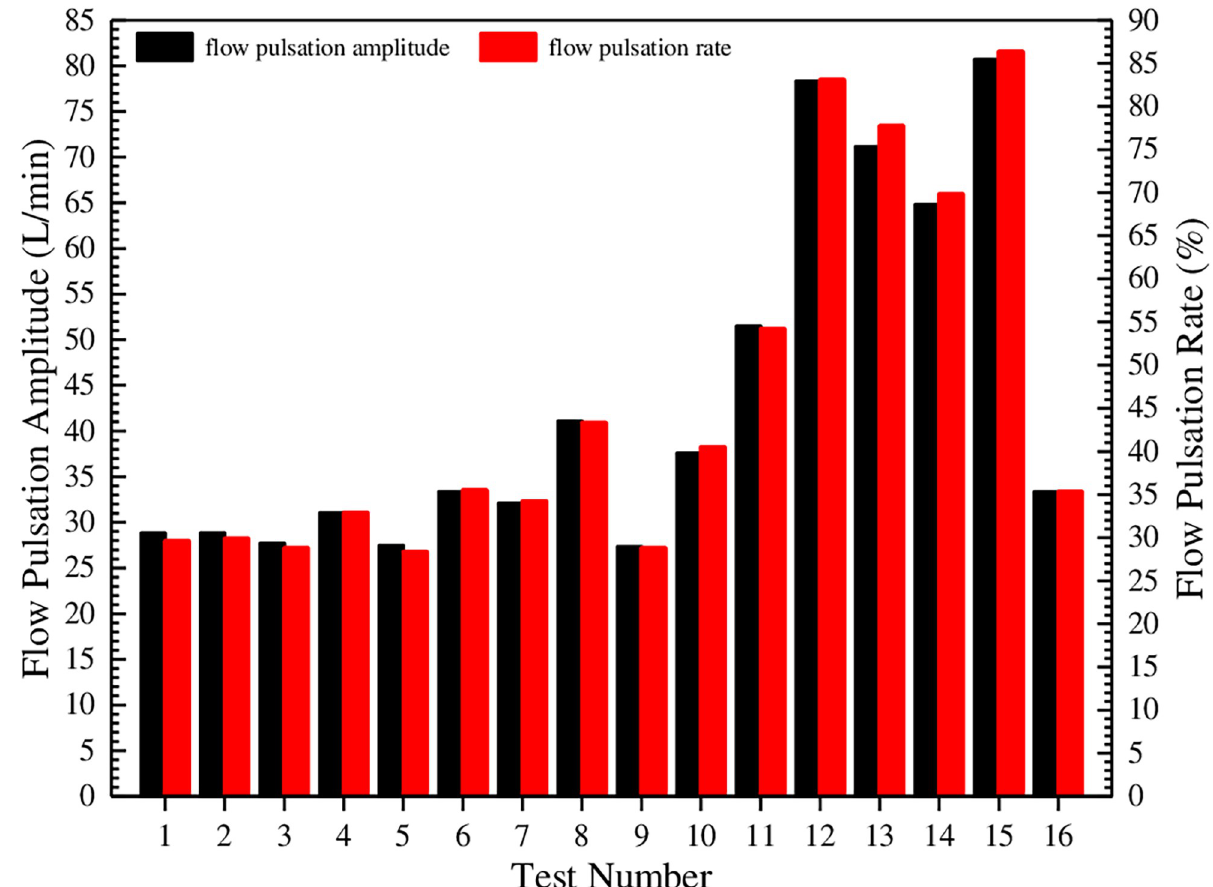
Fig 11. Comparison of flow pulsation amplitude and pulsation rate under different test